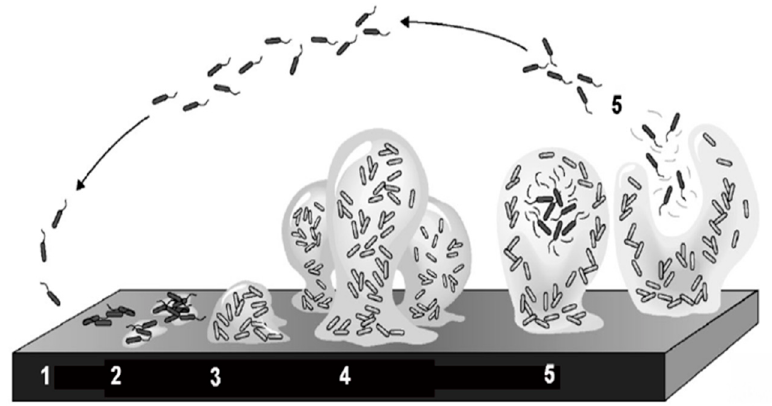
Figure 1. Five stages of biofilm formation and growth (adapted from Stoodley et al., 2002 [2], with permission from © 2002 Annual Reviews Directory. License number: 4131221128126).